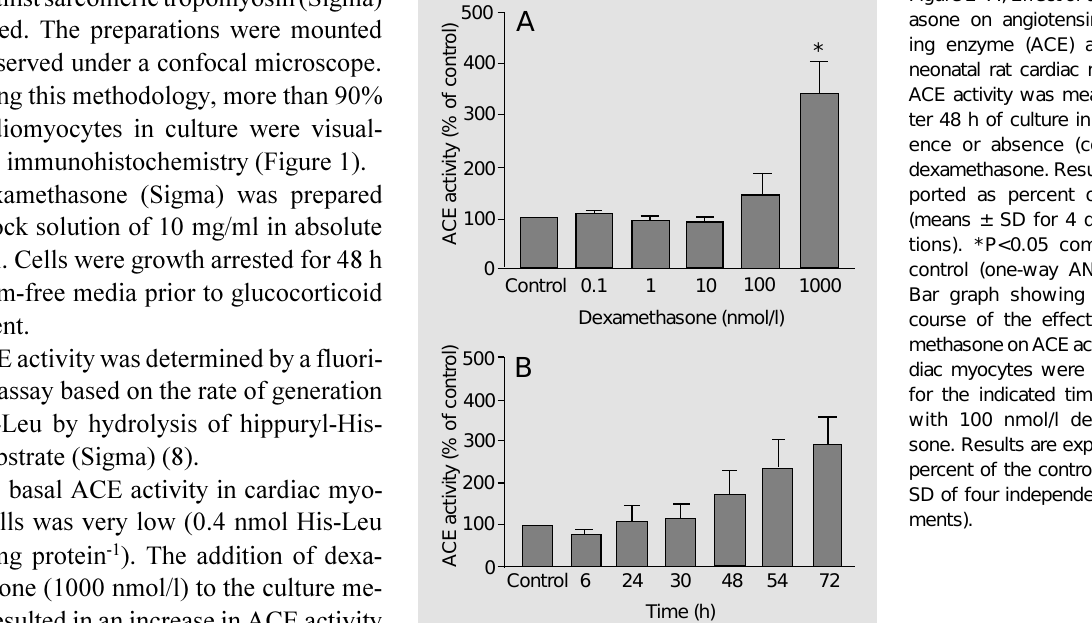
Figure 2 - A , Effect of dexameth- asone on angiotensin-convert- ing enzyme (ACE) activity of neonatal rat cardiac myocytes. ACE activity was measured af- ter 48 h of culture in the pres- ence or absence (control) of dexamethasone. Results are re- ported as percent of control (means ± SD for 4 determina- tions). *P<0.05 compared to control (one-way ANOVA). B , Bar graph showing the time course of the effect of dexa- methasone on ACE activity. Car- diac myocytes were incubated for the indicated time periods with 100 nmol/l dexametha- sone. Results are expressed as percent of the control (mean ± SD of four independent experi-